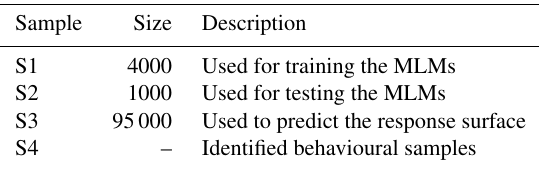
Table 1. Parameter samples used in the building and application of the MLM-based